Question: Write a caption explaining this figure to a reader.
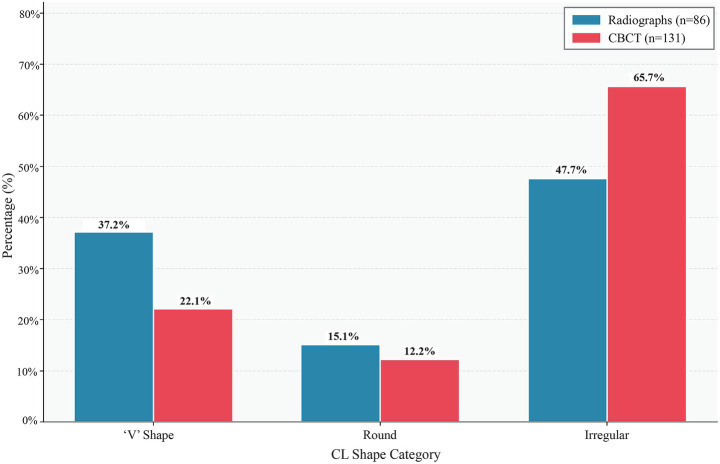
Answer: CL shape distribution in radiographs and CBCT. Only visible cases were included (radiography, n = 86; CBCT, n = 131), using both observers combined. Note that the irregular shape was the most common form observed in both dental radiography and CBCT.